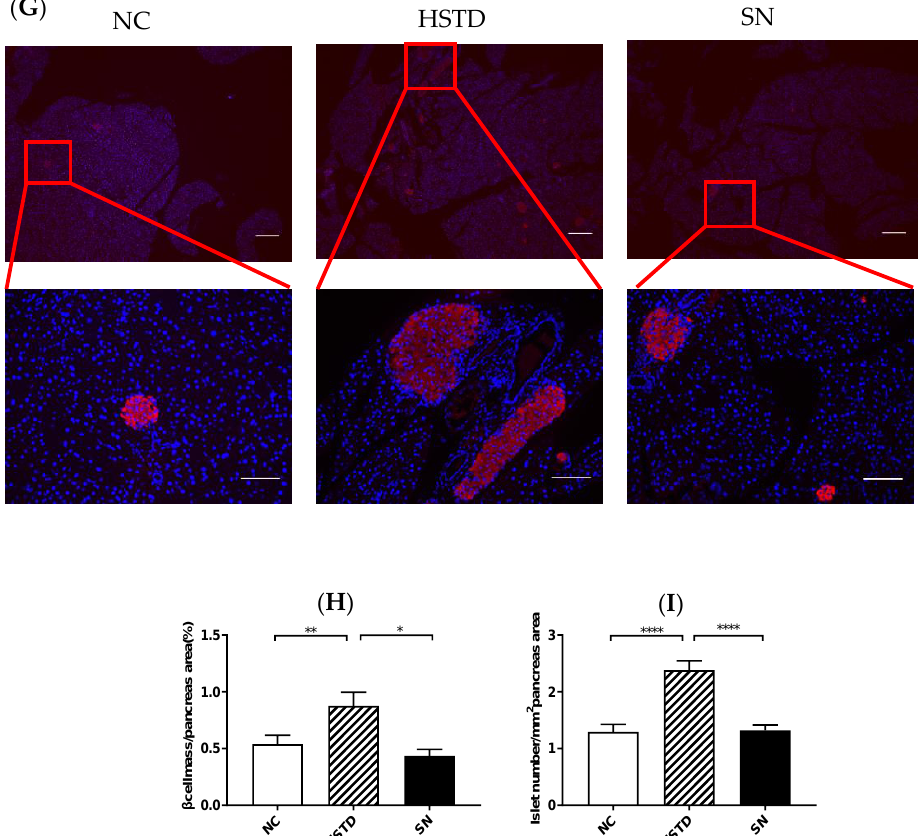
Figure 4. Protocol of this study and the comparison of body weight, metabolic parameters, and morphological analysis of islets between NC group, HSTD group and also mice fed HSTD for 5 weeks followed by NC for 2 weeks (SN) group, 7 weeks after intervention of diet in mice. ( A ) Study design. NC group: Mice fed NC for 7 weeks. HSTD group: Mice fed HSTD for 7 weeks. SN group: Mice fed HSTD for 5 weeks and then fed NC for 2 weeks. ( B ) Body weight, ( C ) blood glucose and ( D ) plasma insulin levels under ad libitum fed condition. NC group (white bar; n = 8), HSTD group (white hatched bar; n = 8) and SN group (black bar; n = 8). ( E ) Blood glucose during IPGTT in NC group (black circle and white bar; n = 8), HSTD group (black square and white hatched bar; n = 7) and SN group (black triangle and black bar; n = 7). ( F ) Blood glucose levels during ITT in comparison to 0 min NC group (black circle; n = 8), HSTD group (black square; n = 8) and SN group (black triangle; n = 8). (* p < 0.05 compared to NC at indicated time). ( G ) The pancreatic section was stained with the antibody to insulin (red) and 40,6-diamidino-2-phenylindole (blue). Scale bars, 300 μm. (H) β-Cell area relative to pancreas area and (I) number of islets relative to pancreas area. NC group (white bar; n = 12), HSTD group (white hatched bar; n = 12) and SN group (black bar; n = 12). Statistical comparisons were done by one-way ANOVA, with Tukey’s multiple-comparison test in ( B , C , D , H , I ), and two-way ANOVA with Tukey’s multiple-comparison test in ( E , F ). Data represent means ± SEM. * p < 0.05, ** p < 0.01, **** p < 0.0001.